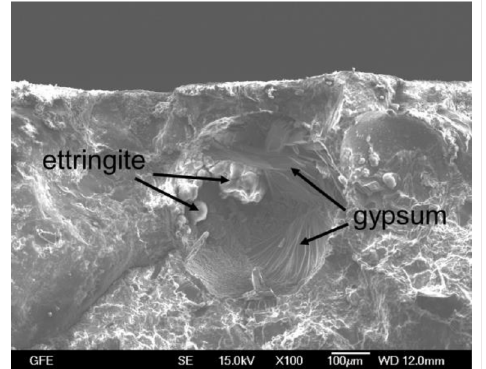
Figure 11. SEM micrographs (surface) of concrete with CEM I 42.5 N (w/c = 0.50) stored for 182 d at 5 ◦ C in Na 2 SO 4 solution with 6000 mg SO 42 − /L.